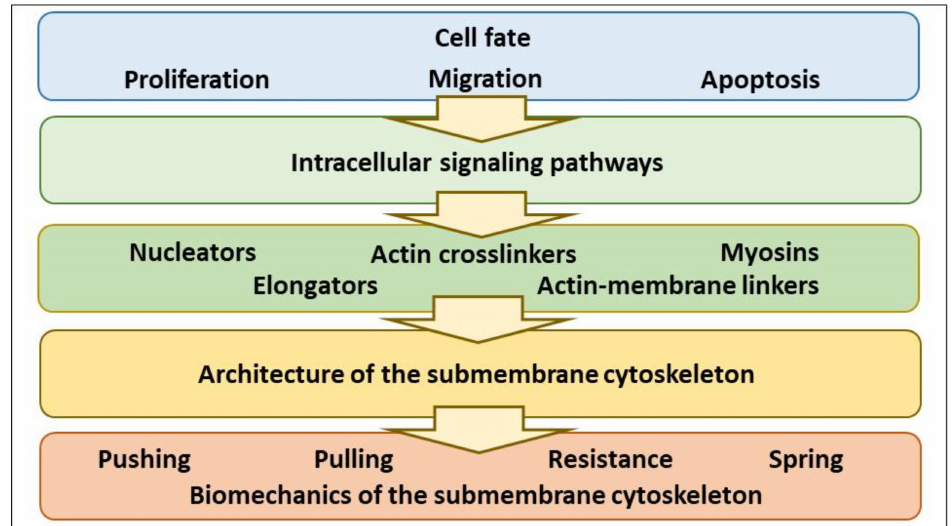
Figure 1. The schematizing of signal transduction from the cell fate-controlling stimuli onto the biomechanics of the PM-smACSK complex.